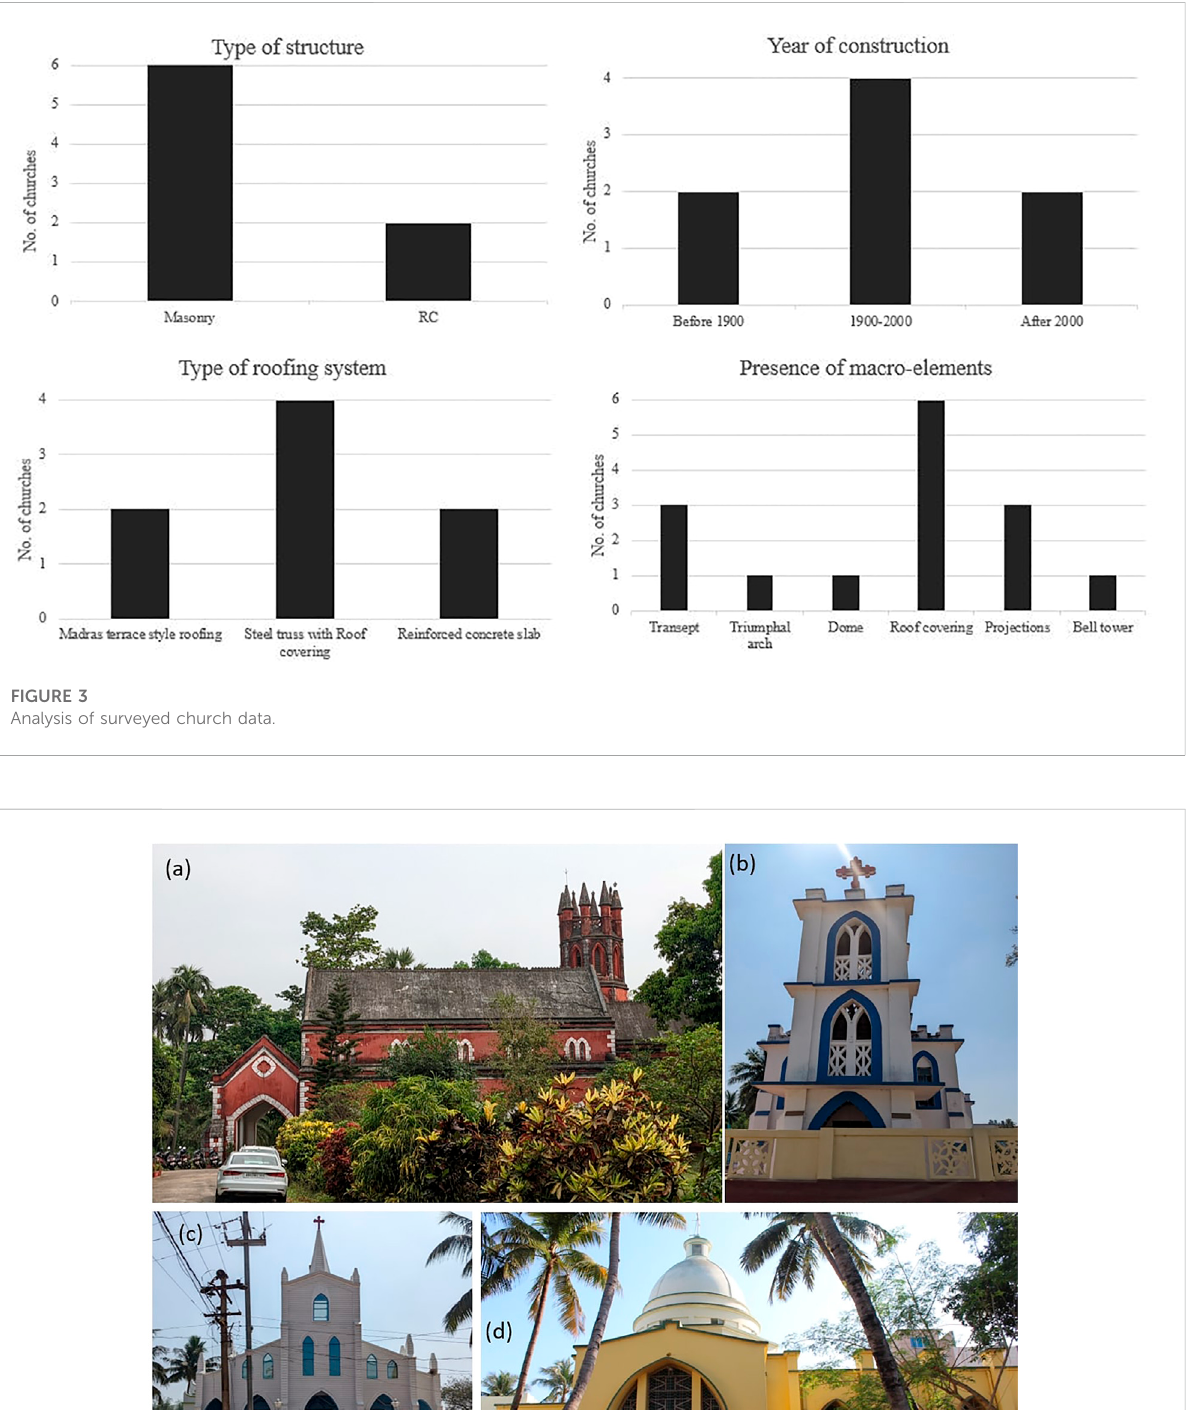
Frontiers in Built